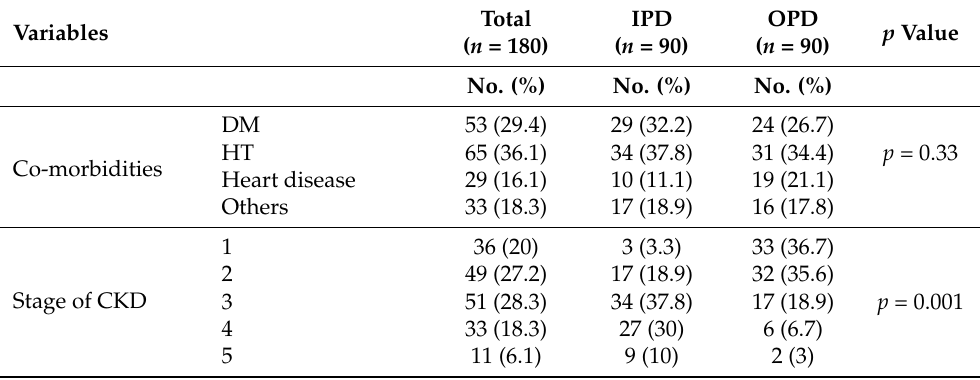
Table 2. Clinical information of the